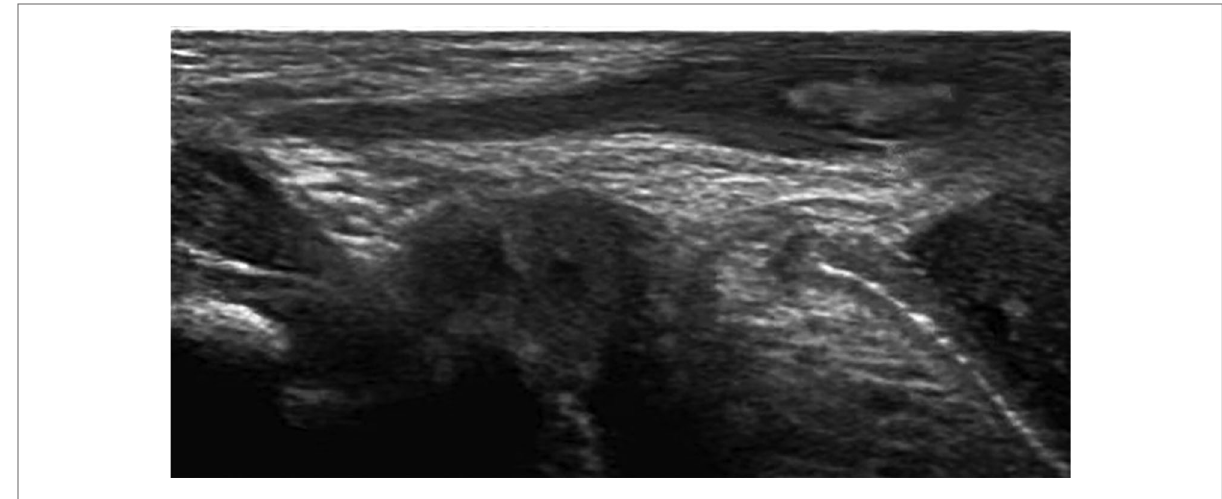
FIGURE 2 Ultrasound scan showing a hyperechoic nubbin located in the